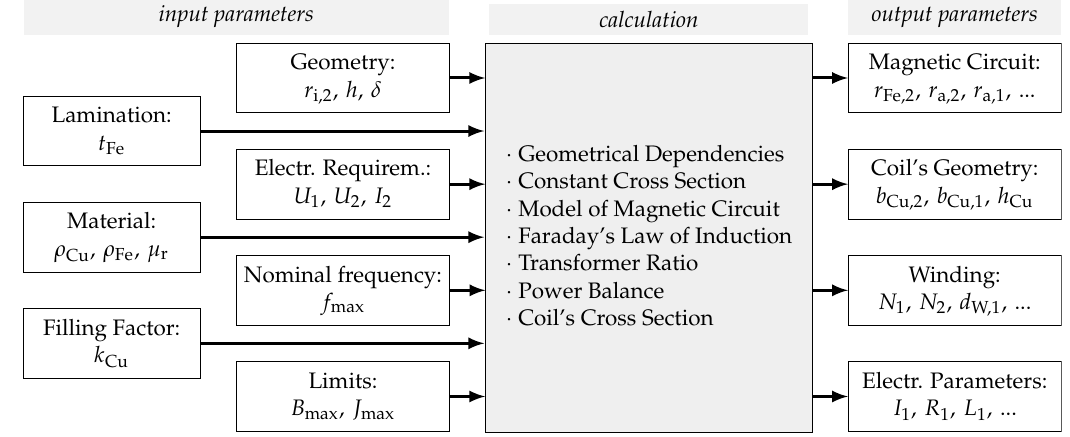
Figure 3. Sketch of Design Process for the CET system as proposed by Silge et al. in